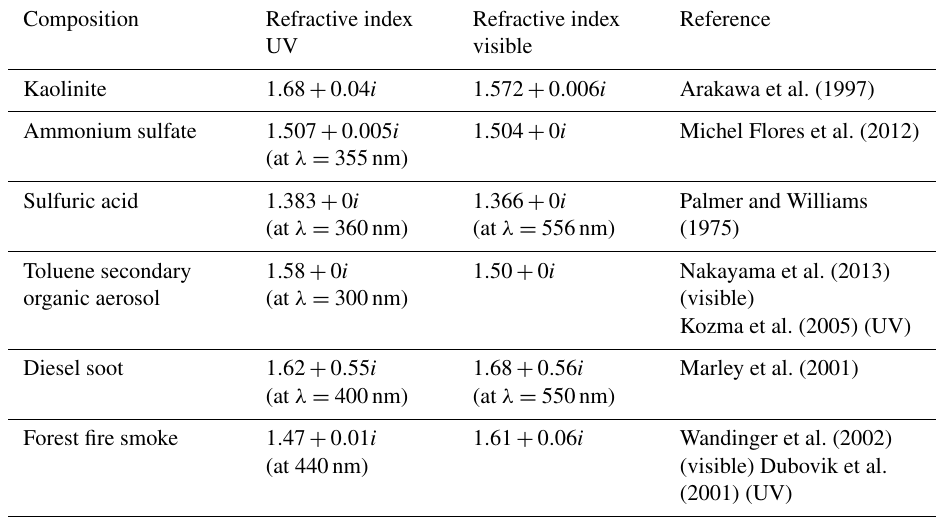
Table 1. Refractive index for particle compositions used in aerosol correction